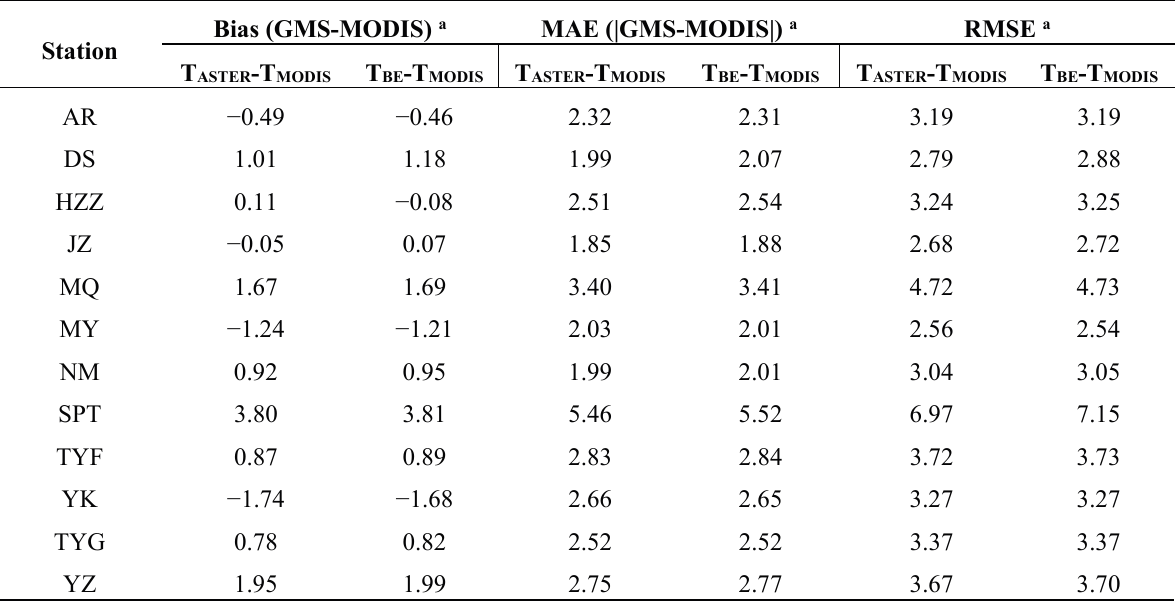
Table 3. Summary of validation